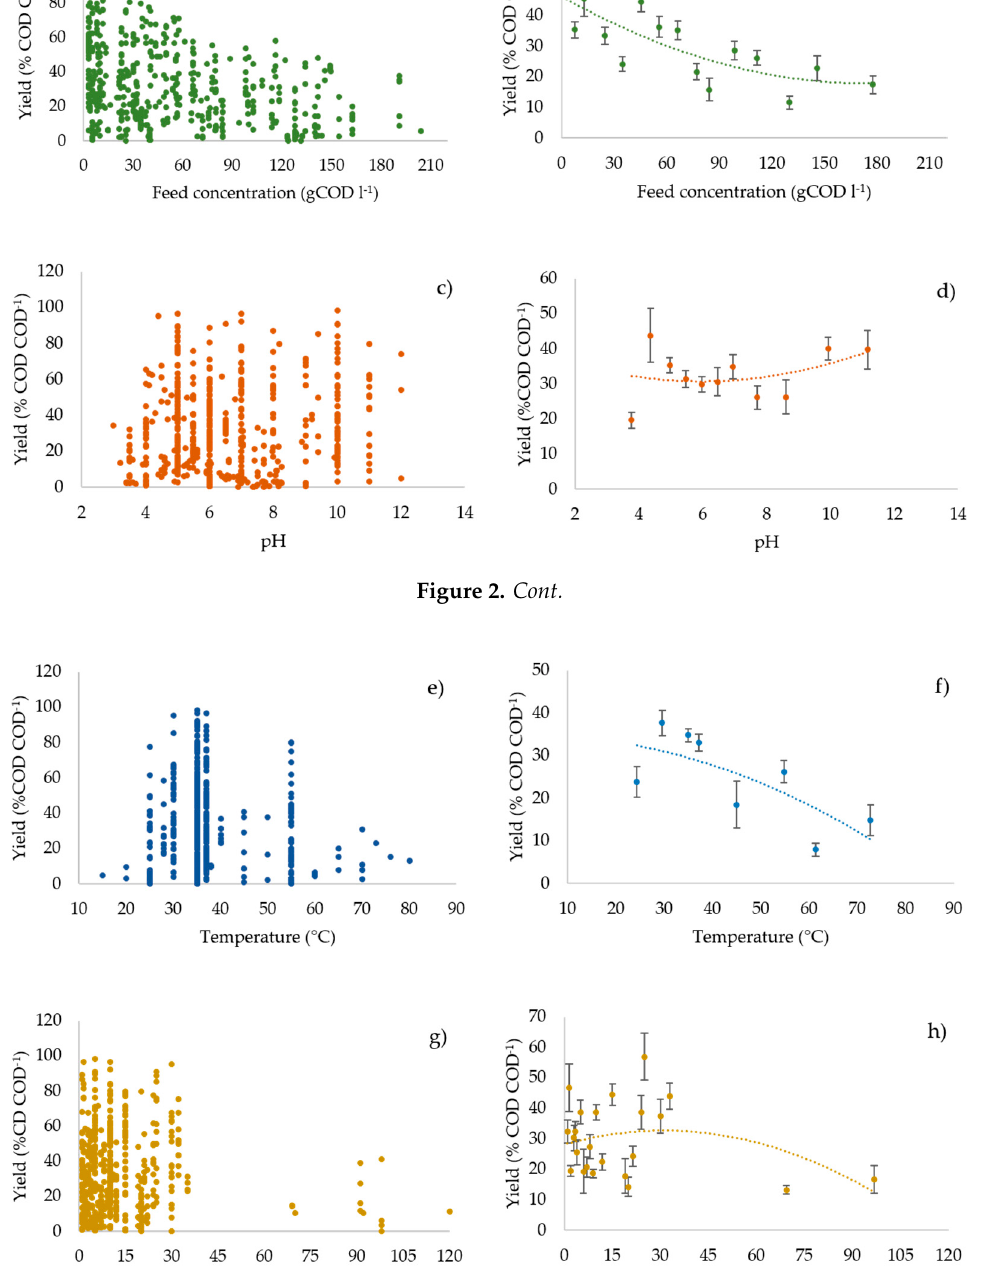
Figure 2. Relationships between product yield and operating parameters. ( a , c , e , g ) All the considered experiments. ( b , d , f , h ) Average values of experiments in each narrow range (width maximum 20%) of the operating parameters (error bars indicate the standard error) with second grade polynomial curve. The polynomial curve is only used to visualise the general trend, without any statistical significance.